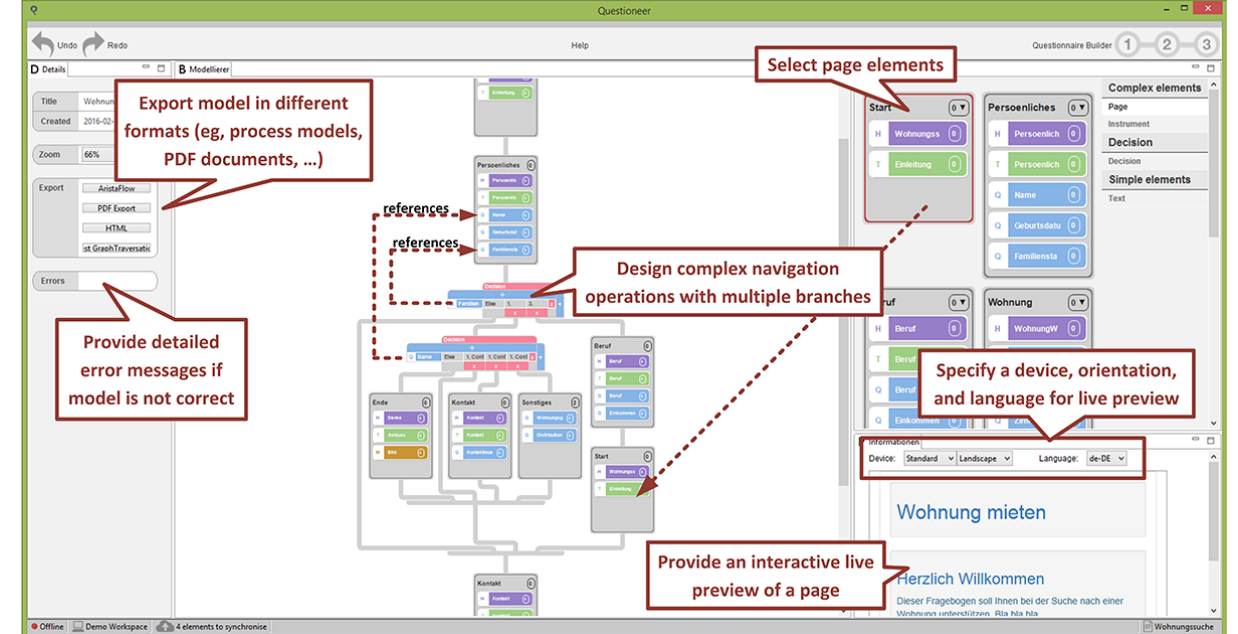
Figure 3. The QuestionSys configurator: modeling a data collection